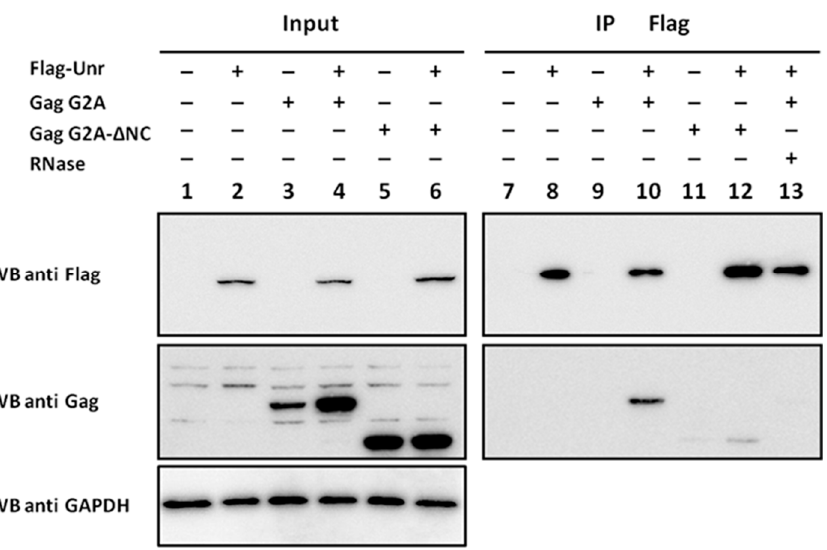
They also indicated that Gag/Unr interaction is RNA-dependent and, to a large extent, mediated by the NC domain.